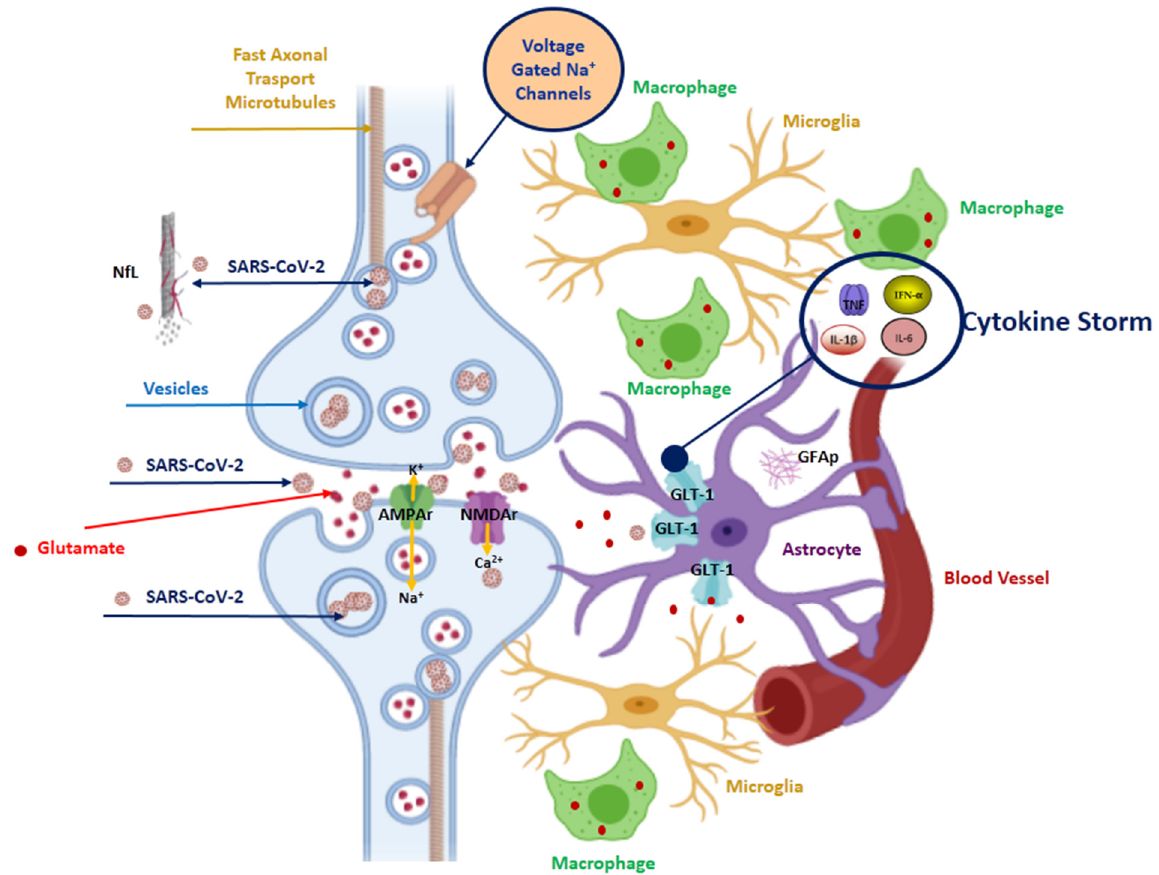
Figure 3. SARS-CoV-2 spreads by transsynaptic viral neuroinvasion from periphery to the brain. The retrograde transsynaptic viral spread occurs via a mechanism of endocytosis or exocytosis and the transport of vesicles occurs along the fast axonal microtubules. Axonal damage is expressed by the increased concentration of NfL in COVID-19 patients. The neuroinvasion of SARS-CoV-2 induces an excess of glutamate at the synaptic level. Moreover, high levels of inflammatory cytokines such as tumour necrosis factor (TNF) and interleukin (IL)-1 β released by activated inflammatory cells, including microglia, astroglia, and macrophages, lead to increases in synaptic glutamate concentrations. SARS-CoV-2 damages macrophages, microglia, and astrocytes. In fact, in COVID-19 patients even with moderate disease, it is possible to find increased glial fibrillary acid protein (GFAp) as a marker of astrocytic activation/injury. Effects of inflammatory molecules on astrocytic cell morphology leads to decreased ability to sequester and contain glutamate within the synapse, resulting in a spill-over of the glutamate into the extrasynaptic space. Increases in synaptic glutamate resulting from early inflammatory changes induced by SARS-CoV-2 invasion have been shown to induce overactivation of intrasynaptic ionotropic receptors, such as α -amino-3-hydroxy-5-methyl-4-isoxazolepropionic acid (AMPA) and N-methyl-d-aspartate receptors (NMDA), potentially contributing to excitotoxicity [28]. This figure was created using the website https://app.biorender.com (accessed on 14 October 2021) .